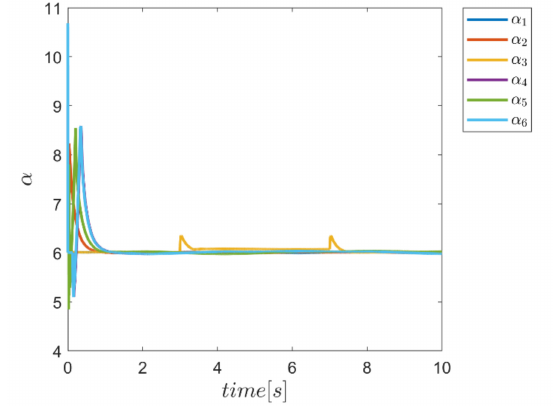
Figure 47. Adaptive variation of the coefficents of α for an individual α fuzzy